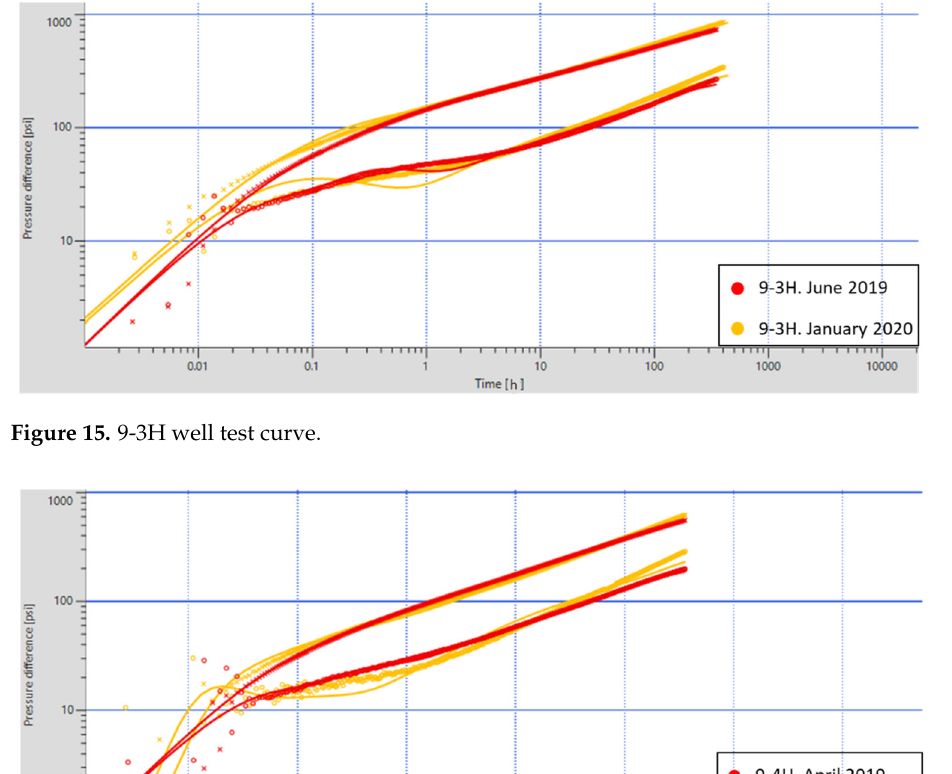
Figure 14. 9 ‐ 1H well test curve.